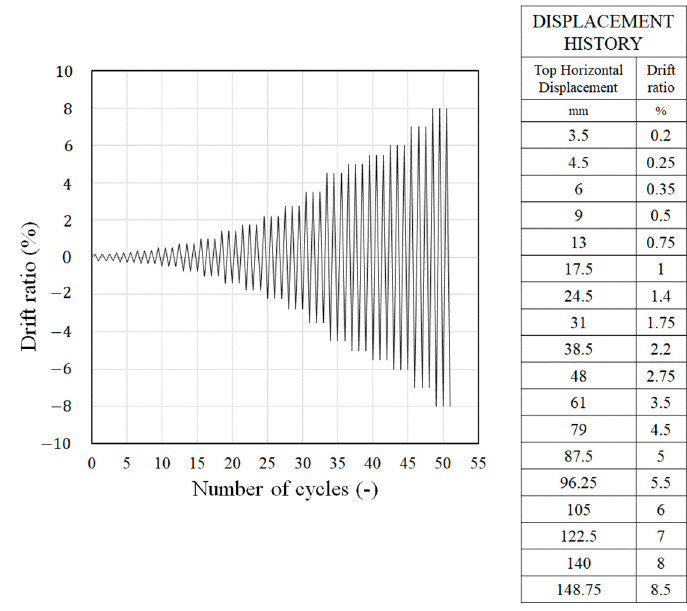
Figure 6. The loading protocol.